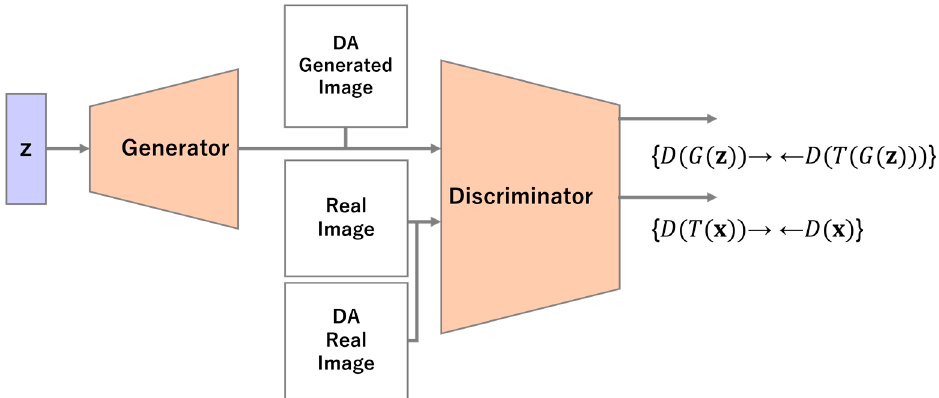
Figure 3. Overview of balanced consistency regularization.